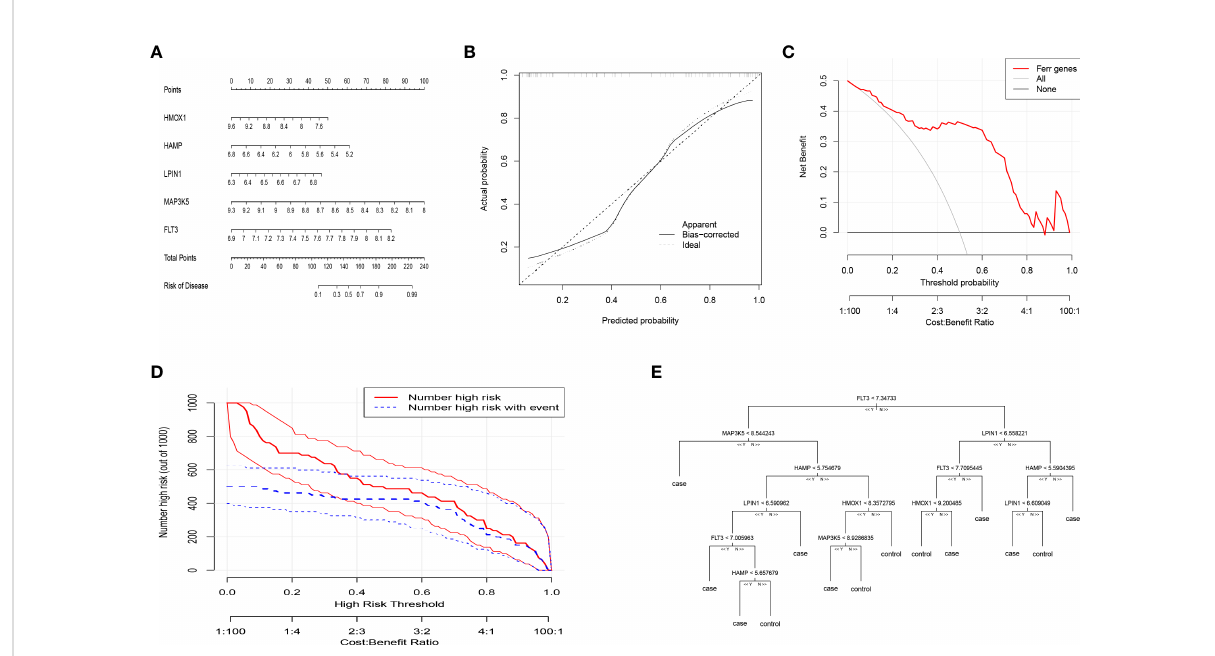
FIGURE 3 Construction of the nomogram model and Machine Learning for Classi fi cation of PMOP and Healthy Woman. (A) Construction of the nomogram model based on the selected DEFAGs (HMOX1, HAMP, LPIN1, MAP3K5, FLT3). (B) Calibration curve illustrating the diagnostic ability of the nomogram model. (C) Nomogram models have higher clinical utility than individual DEFAGs, according to DCA. (D) The clinical impact curve demonstrates a high level of diagnostic ability of the nomogram model. (E) Decision-tree diagram showed the results of gene expression levels that determine PMOP or a healthy